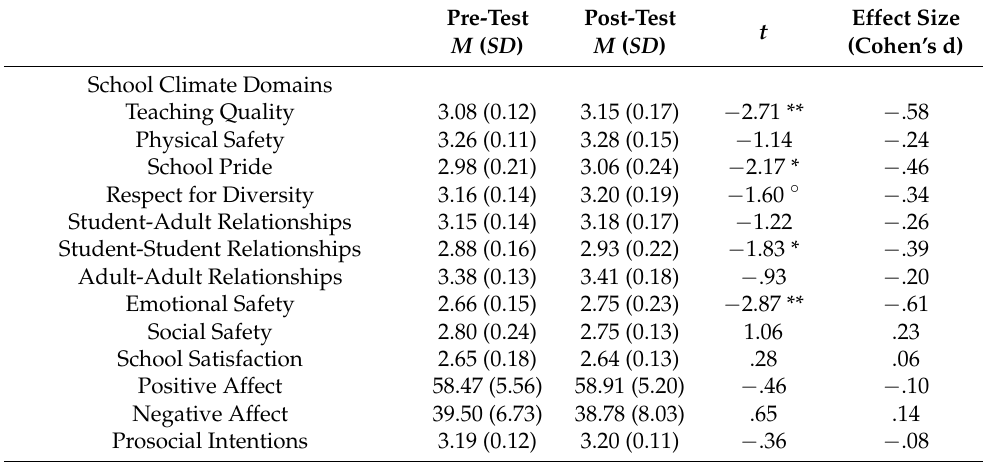
Table 3. School-Level Changes in School Climate and Student Affective